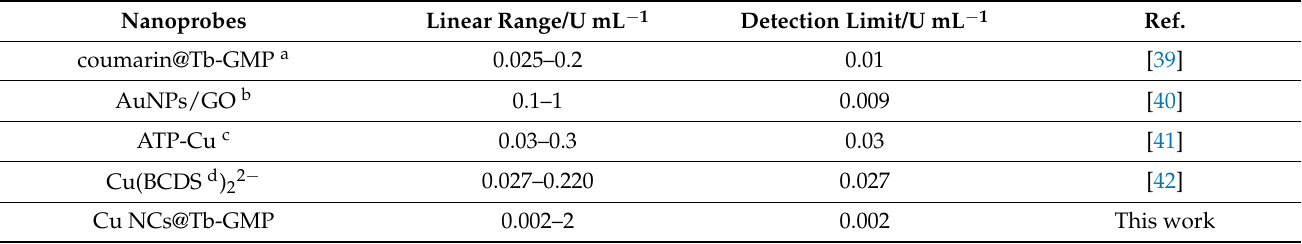
Figure 4. ( A ) The response of the Cu NC@Tb-GMP sensor when exposed to ALP solutions with different concentrations. The inset displays the corresponding images of ALP solutions with different concentrations under 365 nm UV light. ( B ) The plot of the response of the Cu NC@Tb-GMP ratiometric fluorescent sensor as a function of the concentration of ALP. ( C ) The response of the Tb-GMP sensor when exposed to ALP solutions with different concentrations. Table 1. A comparison of ALP detection of different kind of fluorescent